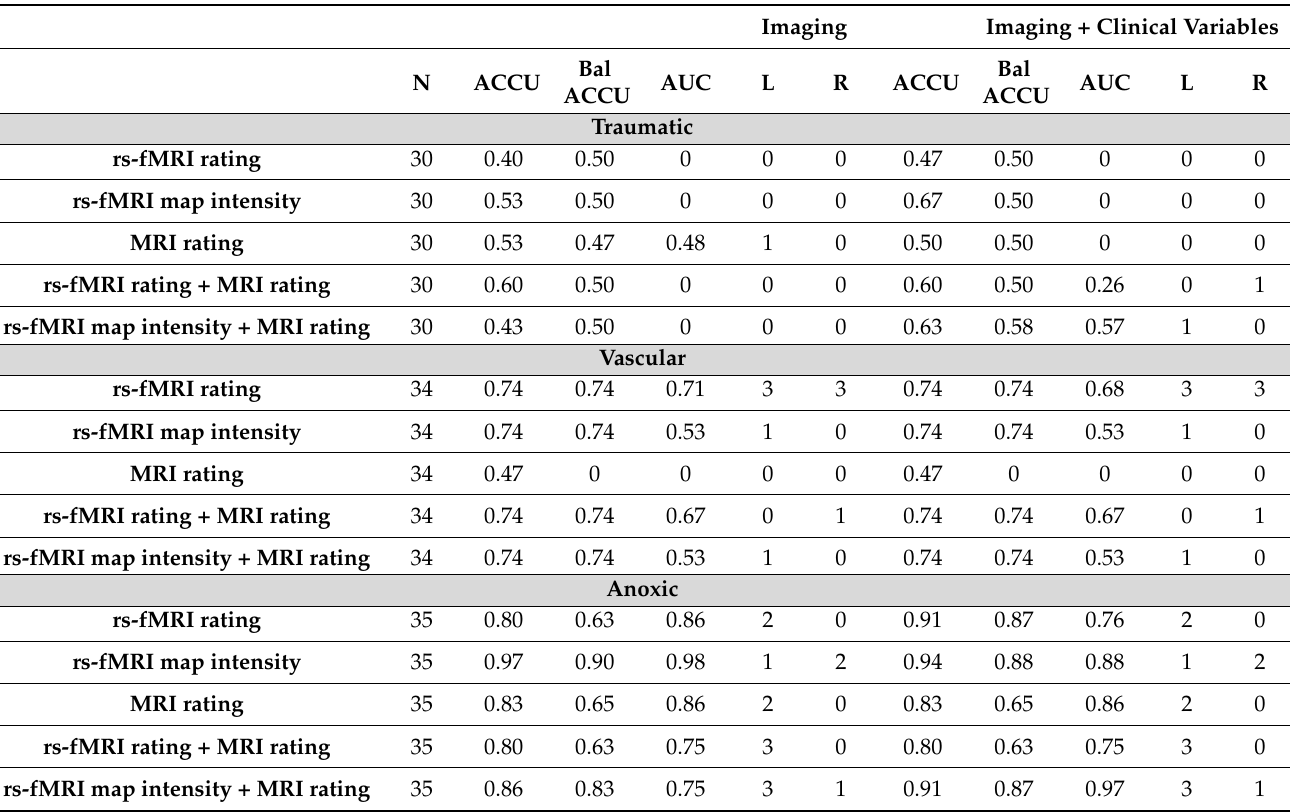
Models refer to imaging and imaging + clinical variables; balance accuracy = 0.64 and AUC = 0.71. N = number of patients; ACCU: accuracy; Bal ACCU: balanced accuracy; AUC: area under the curve; L: number of variables for the left hemisphere; R: number of variables for the right